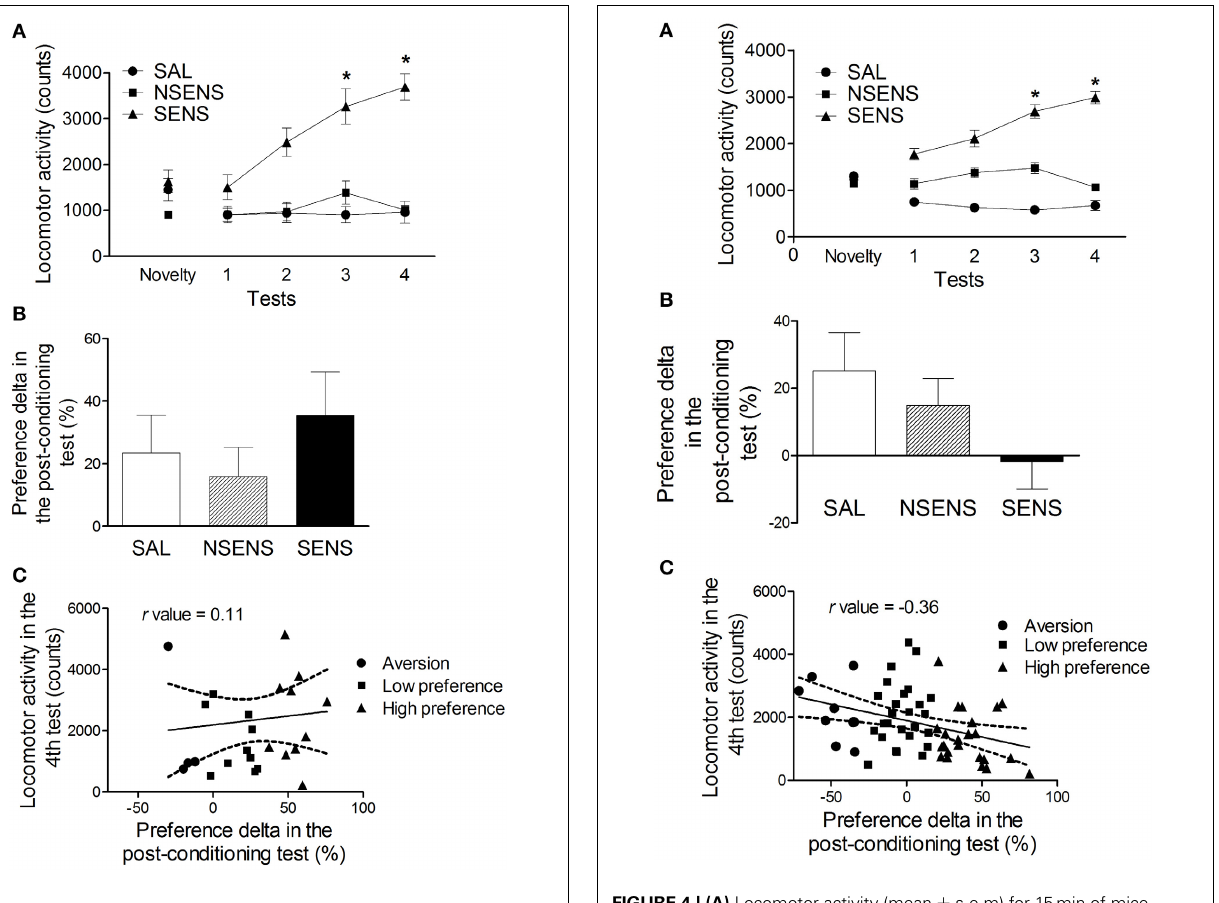
FIGURE 3 | (A) Locomotor activity (mean ± s.e.m) for 15min of mice treated with saline (SAL) ( n = 9) or 2.2g/kg ethanol (NSENS = 8; SENS = 8) in the novelty-exposure test and in tests 1–4 (Experiment 3A). Based on their activity in test 4, the ethanol-treated mice were classified as “sensitized” or “non-sensitized.” ∗ Higher than SAL and NSENS groups on the same test ( P < 0 . 05) and higher than their own levels in test 1 ( P < 0 . 05). (B) Preference delta for the CS + compartment (mean ± s.e.m) in the post-conditioning test of ethanol-conditioned mice (Experiment 3A) classified as saline (SAL), “non sensitized” (NSENS) and “sensitized” (SENS) in the behavioral sensitization protocol. (C) Pearson’s correlation ( r = 0 . 11, P > 0 . 05) between the preference delta in the post-conditioning test and the locomotor activity on test 4 of ethanol-treated mice. Each point represents a single animal classified according to its preference for the CS + compartment, determined by the classification model described in the text (See Table 1 ).